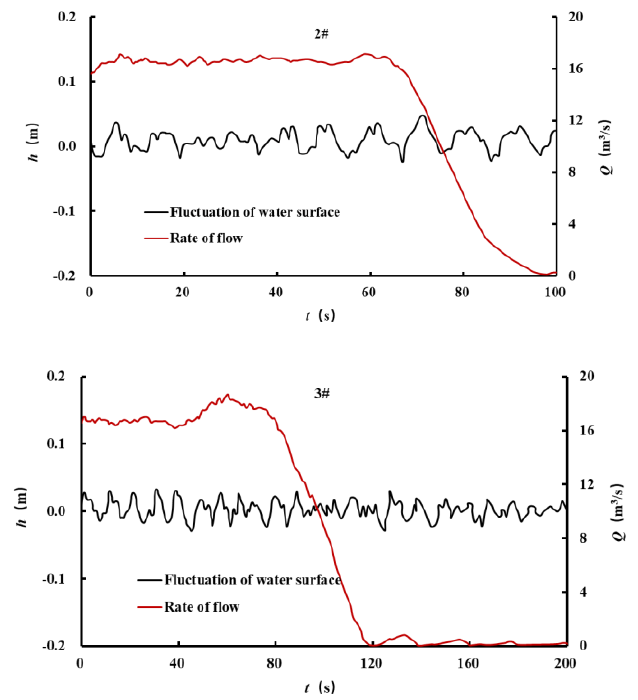
Figure 10. Fluctuation of the water surface from the shafts and rate of flow.